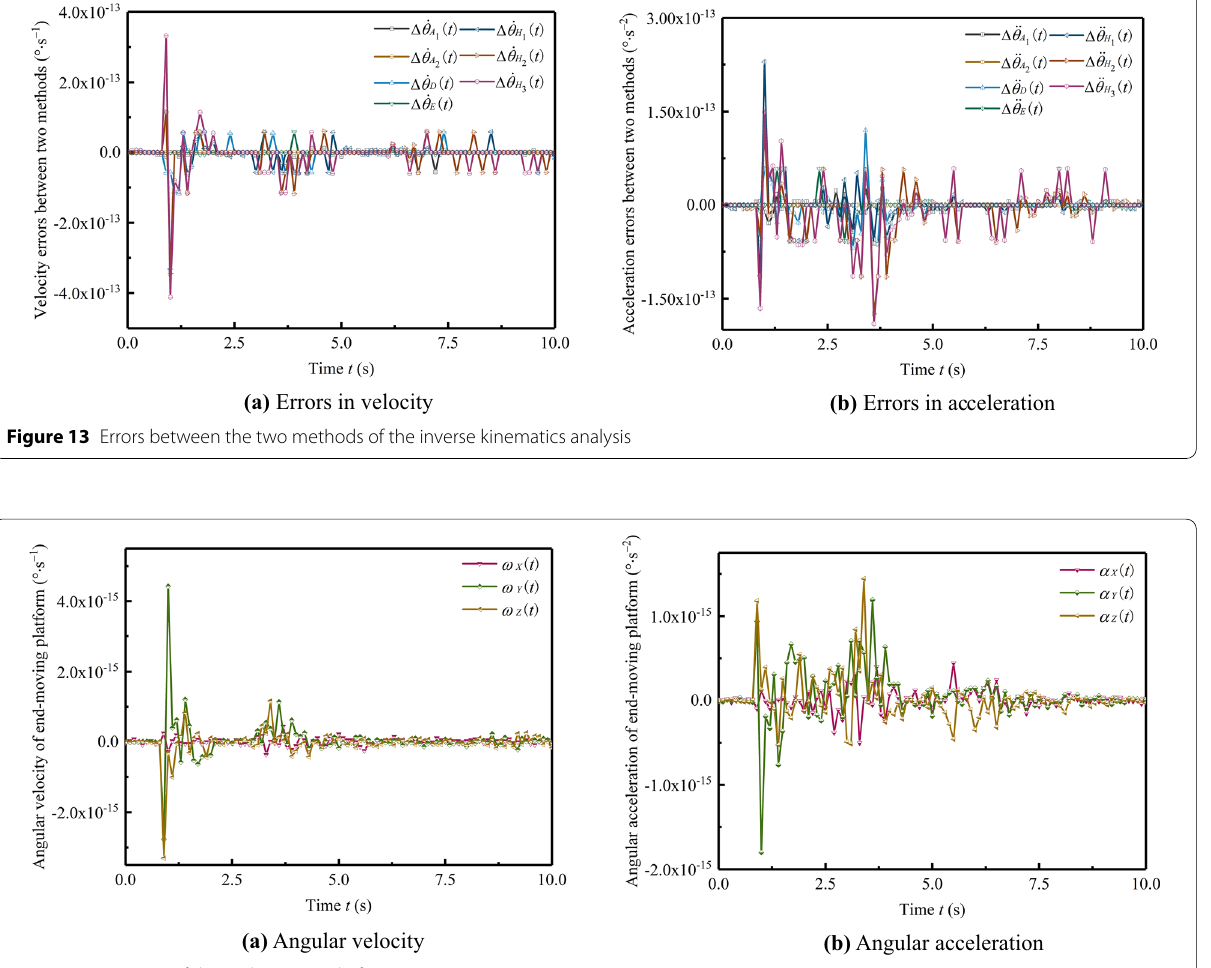
Figure 14 Rotation of the end-moving